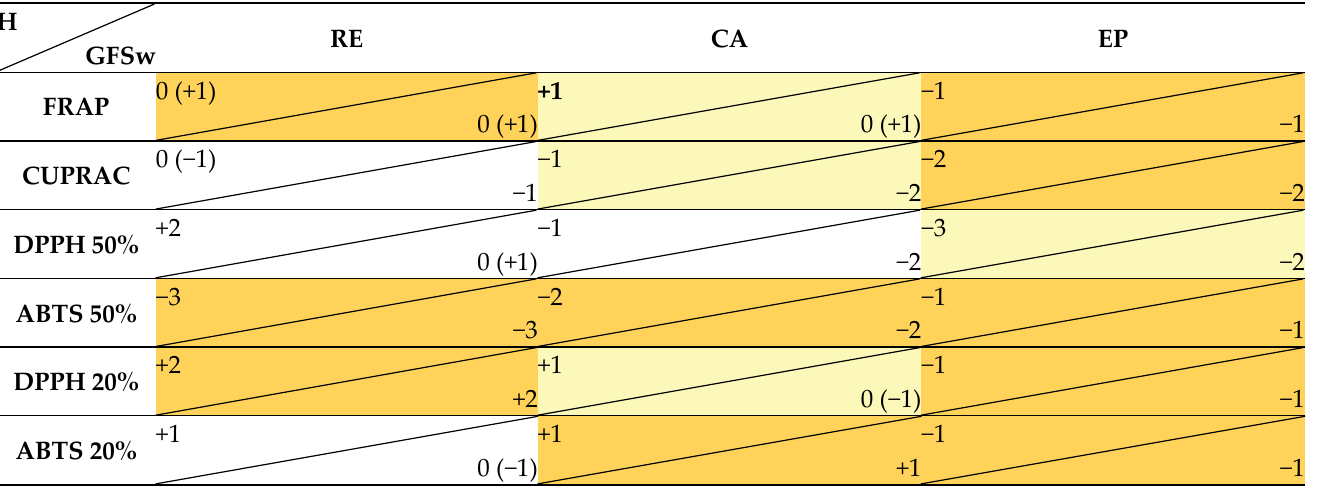
Table 9. CI value intervals and color codification for AOA activity *.